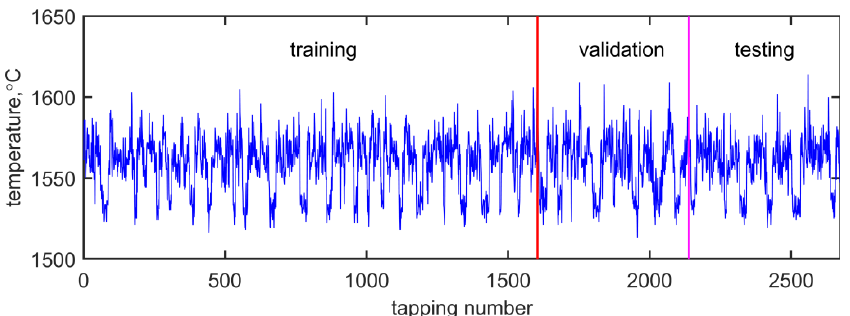
Figure 4. Evolution of the end temperature of liquid steel in VTD system.